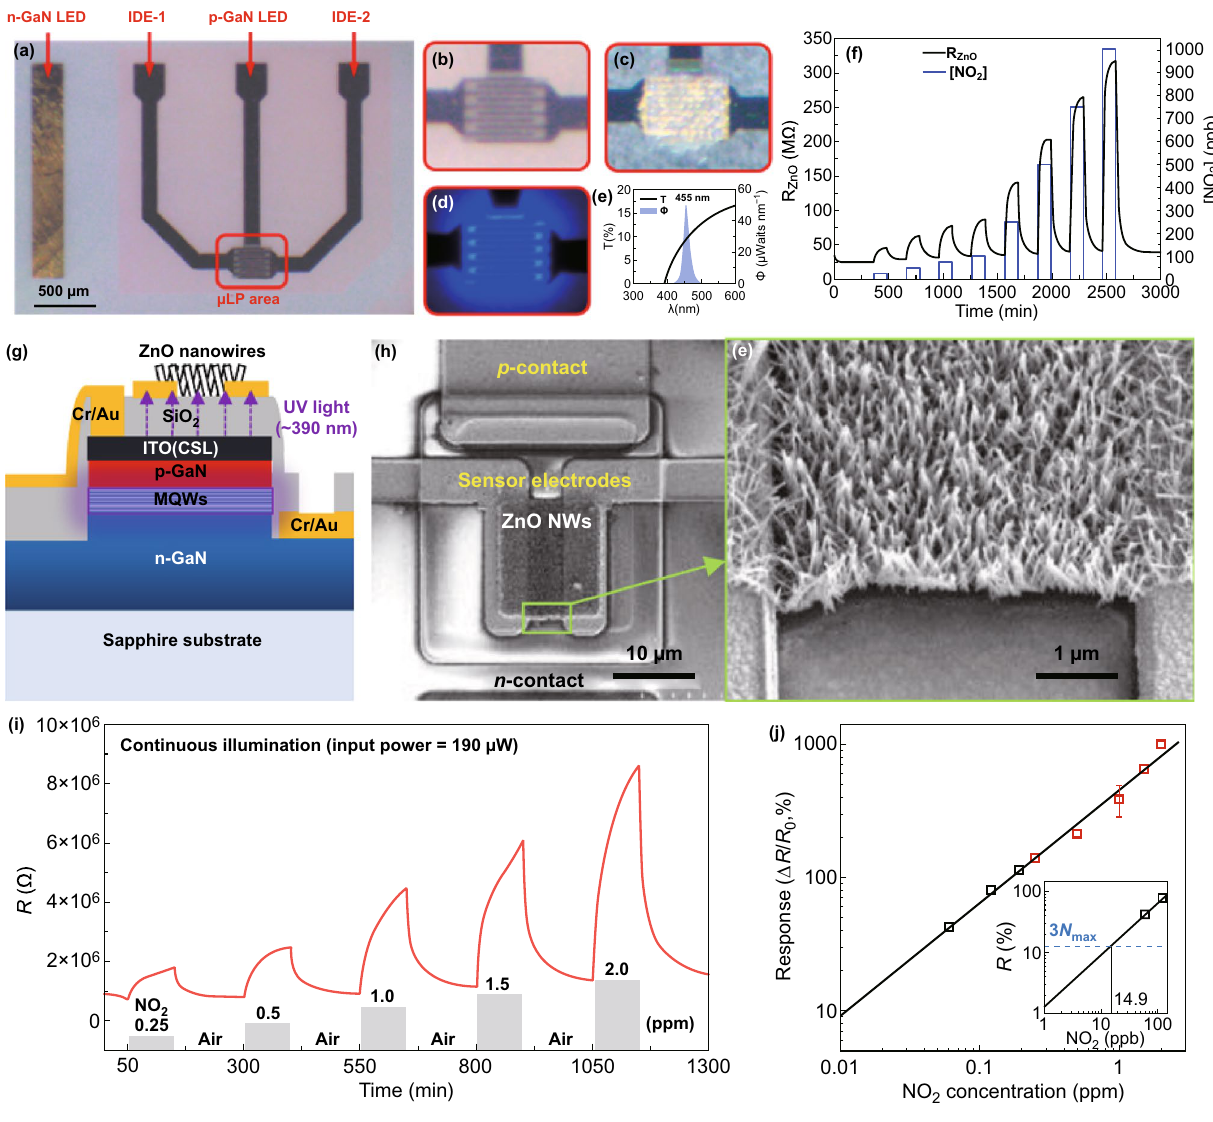
Fig. 4 a Overview of the sensor device with ZnO nanoparticles on top of the micro-LED. Details of the sensor device b bare IDE, c ZnO material on top of the IDE, and d LED light on. e Light emission spectrum of the micro-LED and light transmission spectrum of the ZnO layer deposited on a sapphire substrate. f Resistance transient of the sensors to increasing NO 2 concentrations. Reproduced with permission [60]. Copyright 2019, American Chemical Society. g Schematic cross section illustration of the photoactive sensor with ZnO nanowires grown on a micro-LED. h SEM images of ZnO nanowires on the micro-LED. i NO 2 sensing performance of the photoactive under operating power of 190 μW and j calibration of normalized sensor response to NO 2 . Reproduced with permission [61]. Copyright 2020, American Chemical